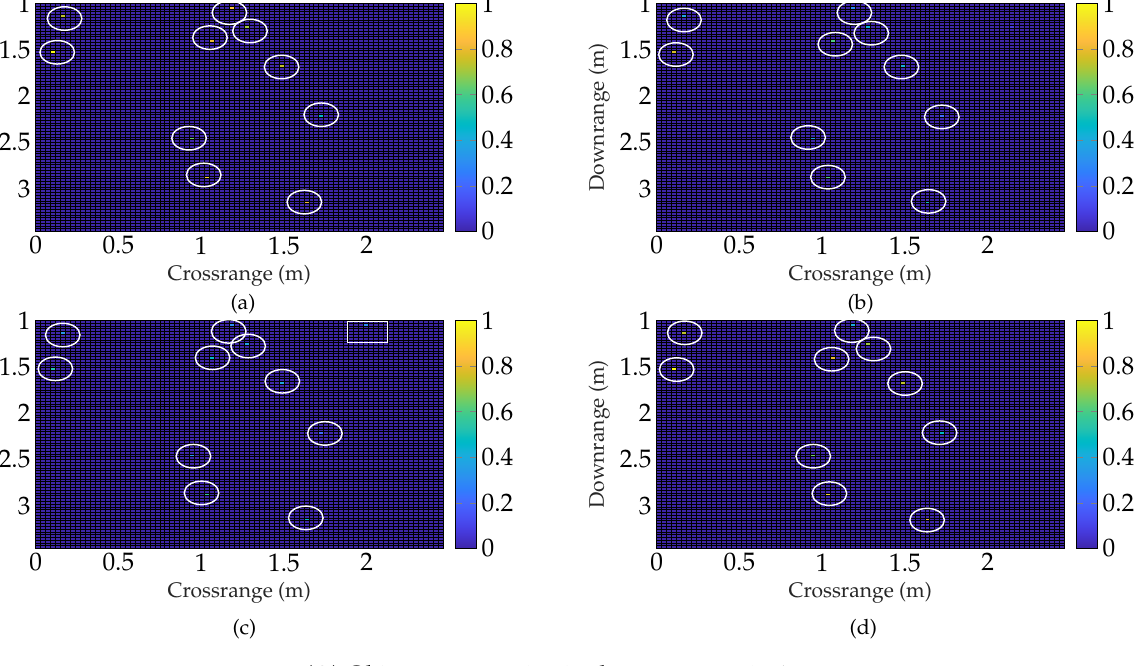
( A ) Object recovery in single case-scenario 1. Figure 16. Cont